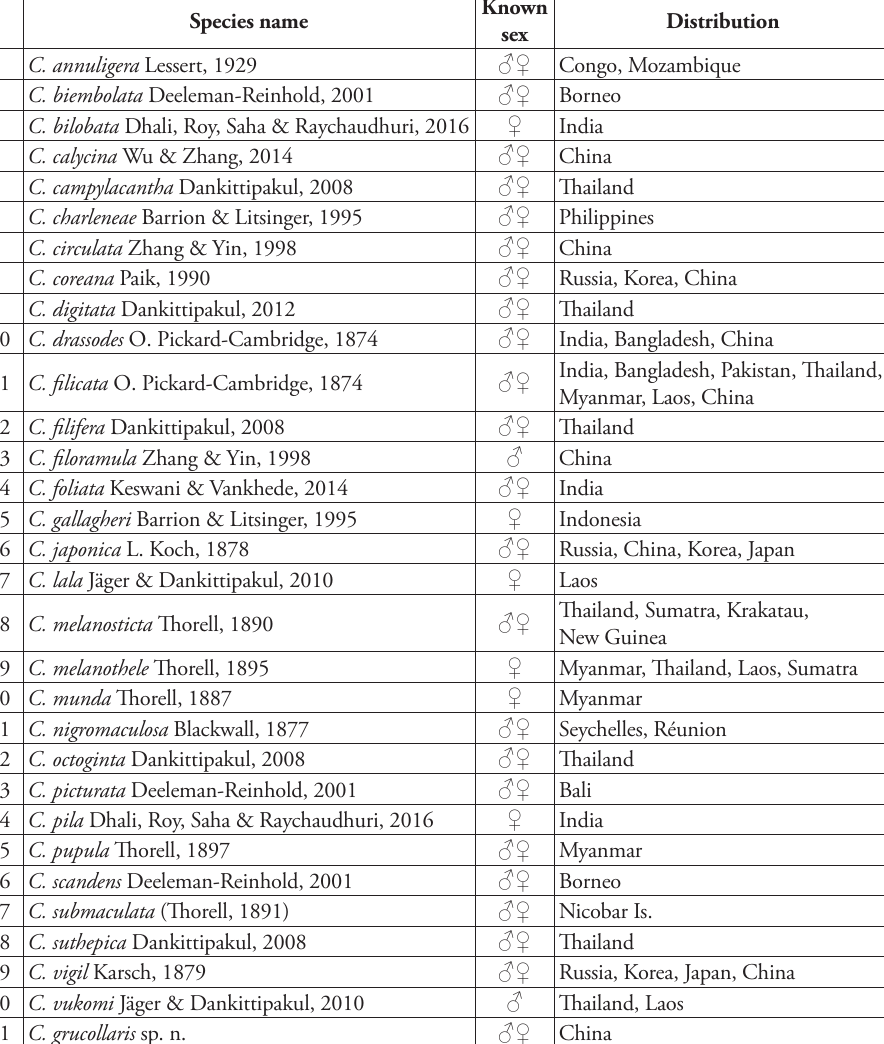
Table 1. A list of current Clubiona japonica -group species in alphabetical order. Species